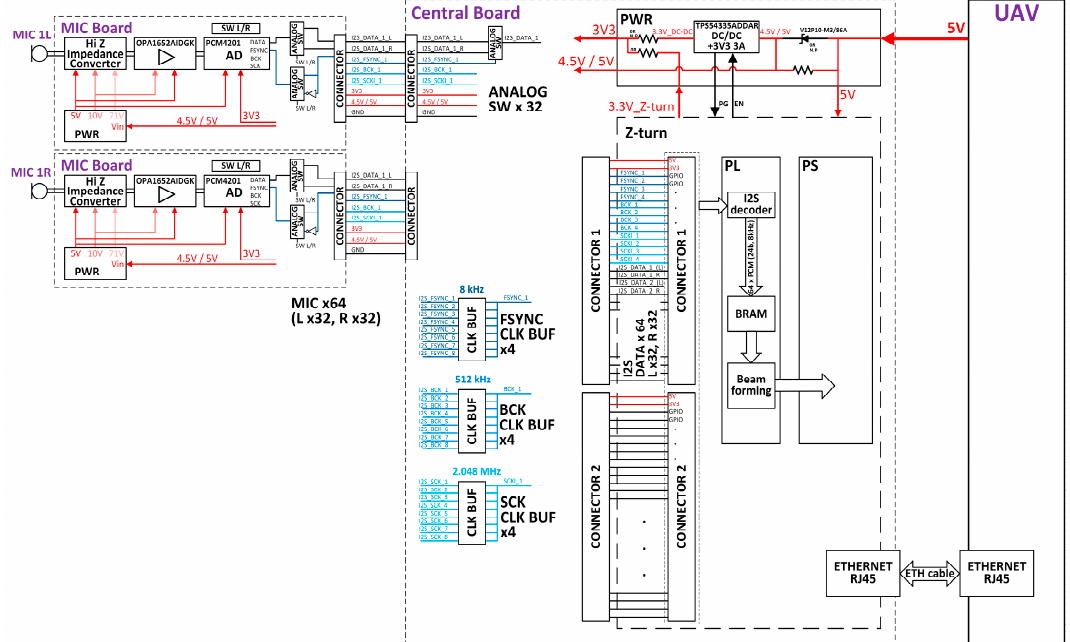
Figure 4. Hardware architecture of the acoustic camera.